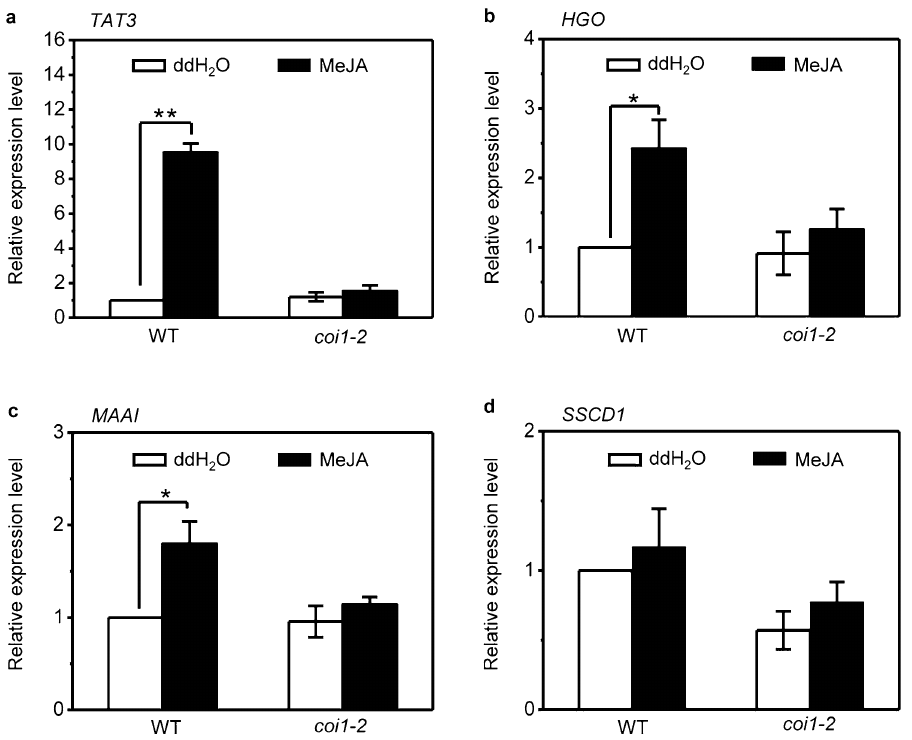
Figure 6. Exogenous MeJA up-regulates the expression of Tyr degradation pathway genes TAT3 , HGO , and MAAI and this up-regulation is dependent on COI1 . ( a – d ) Relative expression level of Tyr degradation pathway genes TAT3 ( a ), HGO ( b ), MAAI ( c ) and SSCD1 ( d ) in wild-type (WT) and coi1-2 seedlings that were grown under LD for 7 days, and then transferred to SD and treated with ddH 2 0 or 100 μM MeJA for 3 days. MeJA, methyl jasmonate; LD, long day; SD, short day. The expression of genes was analyzed by RT-qPCR, relative expression level was normalized to those of ACTIN2 and the control (in wild type without MeJA treatment) was set to 1. Mean ± SE from three biological replicates. Asterisk * and ** represent the significance of differences (two-tailed Student’s t-test) at the levels of P < 0.05 and P < 0.01,